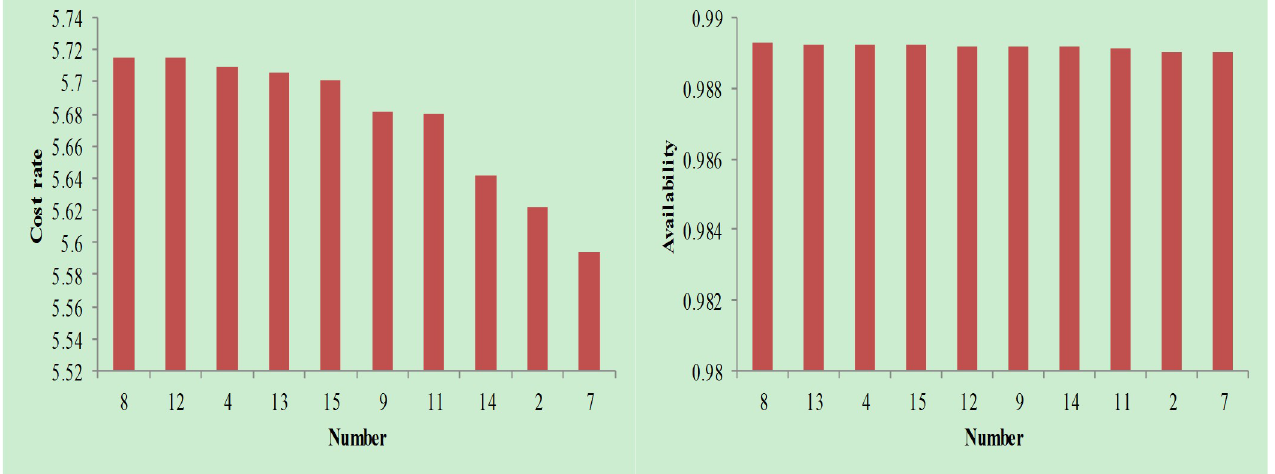
Fig 8. Cost rate and availability analysis when follow-up maintenance cost and downtime take the middle value.